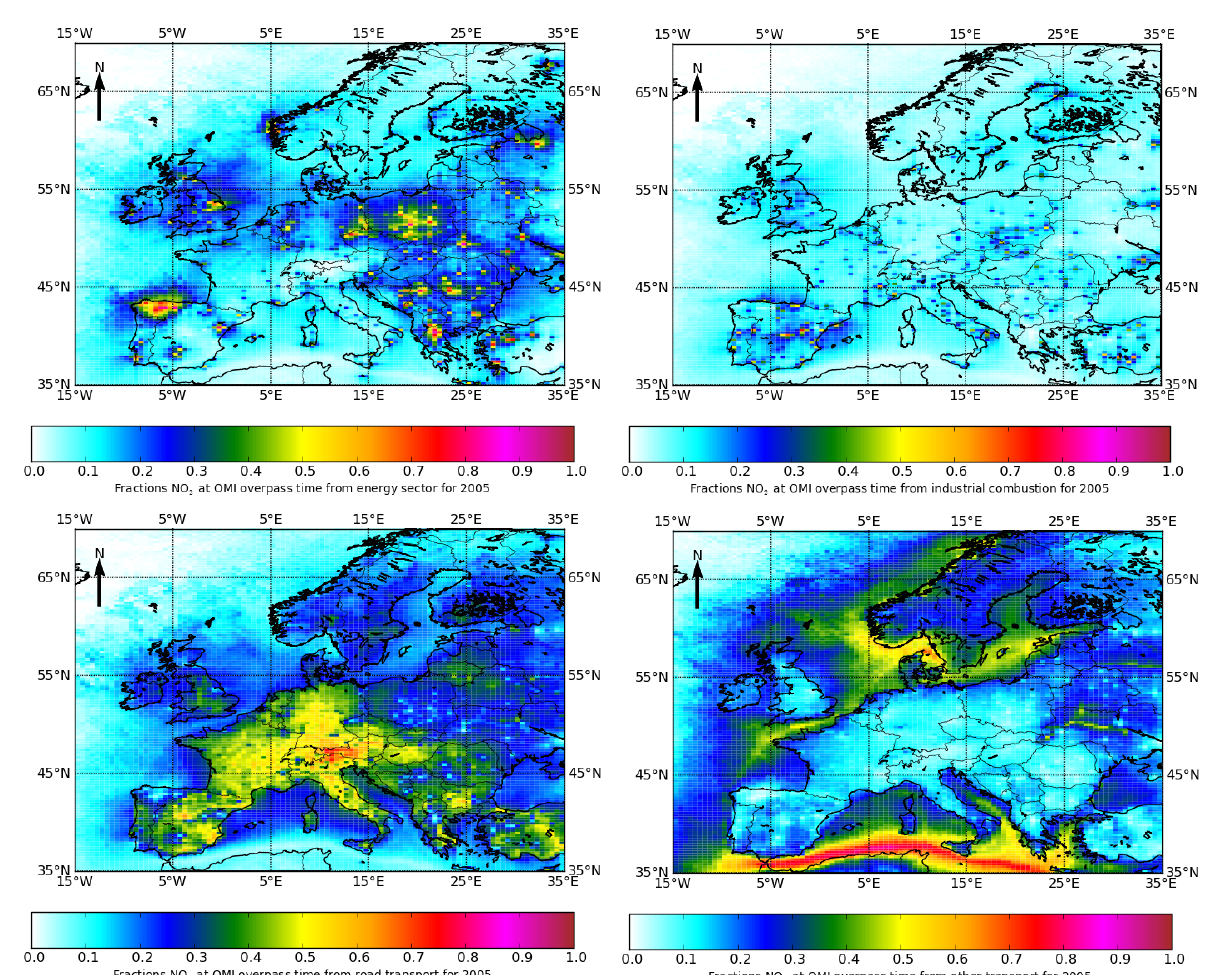
Figure 6. Modeled fractional contributions of power generation ( upper left ), industrial combustion ( upper right ), road transport ( lower left ) and other mobile sources ( lower right ) to the OMI-NO column in 2